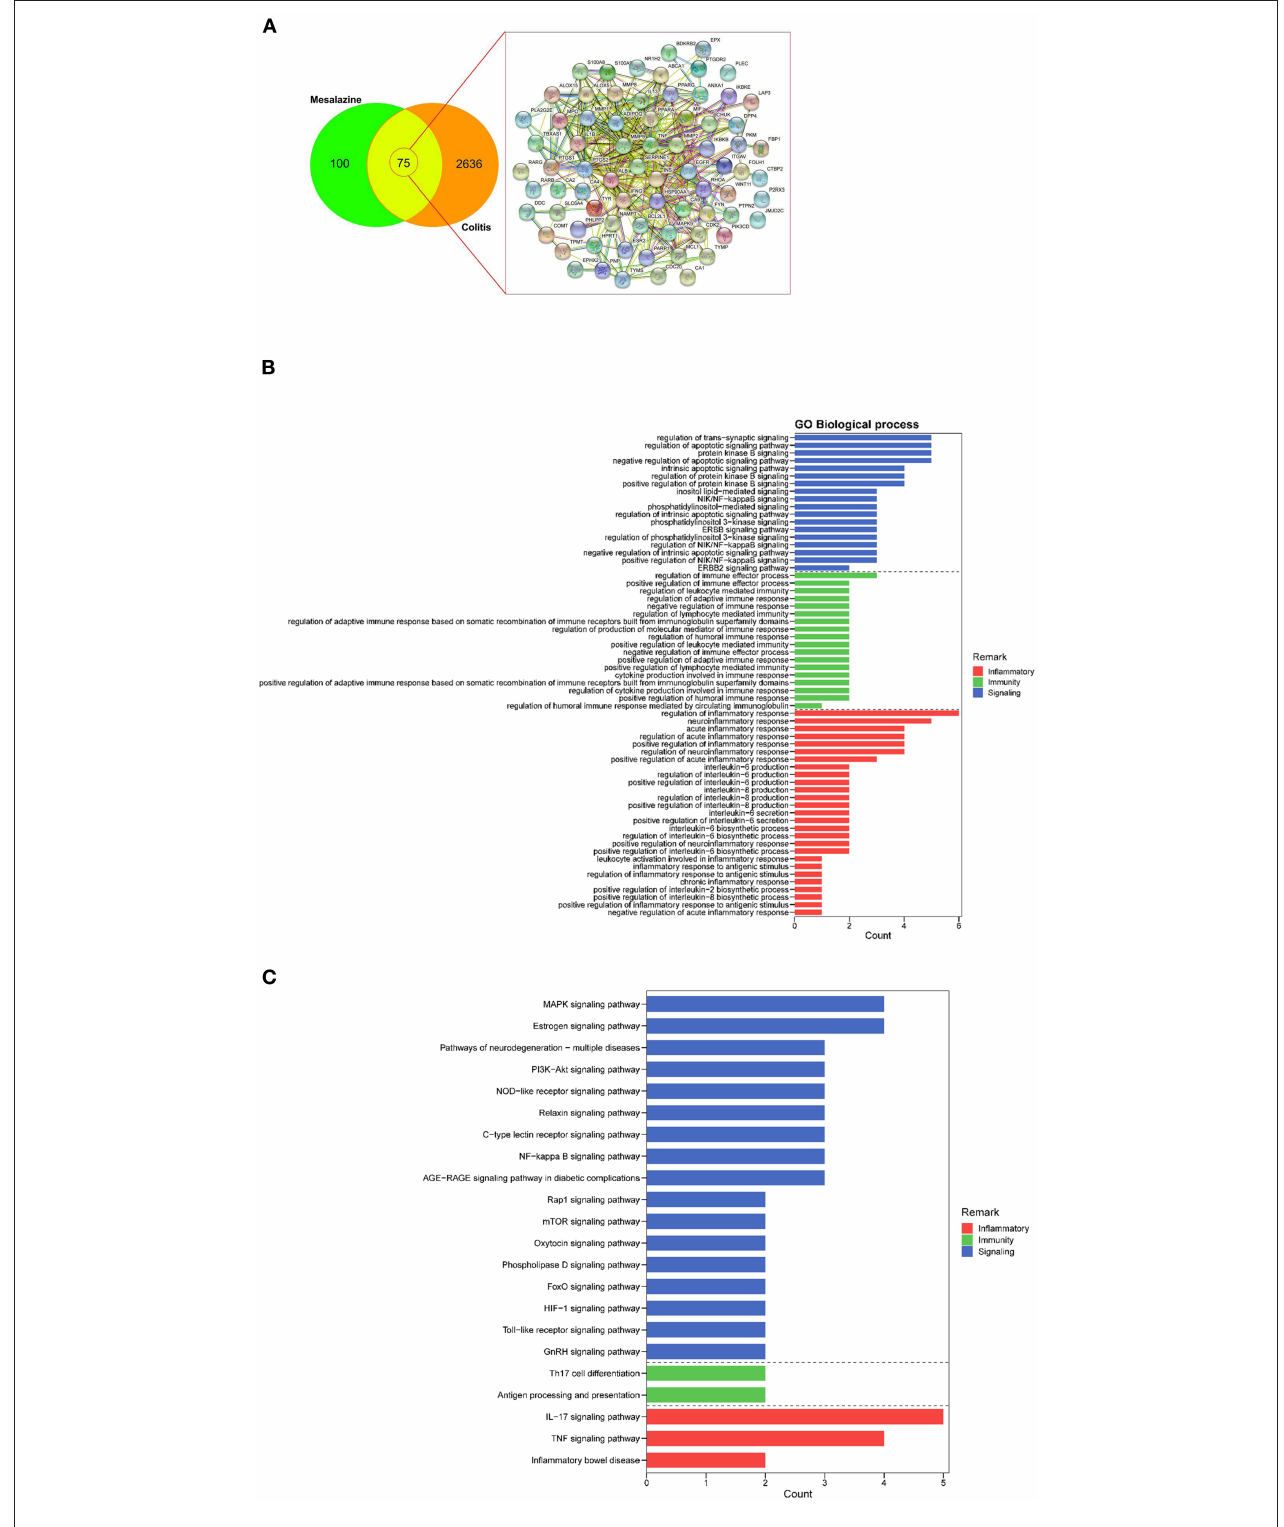
FIGURE 1 | The identification of mesalazine (MZ)- and ulcerative colitis (UC)-associated genes and their immunosuppressive effect. (A) Venn diagrams show the number of common MZ- and colitis-associated genes. (B) The GO enrichment analysis highlighted the biological processes related to immunosuppressive effect